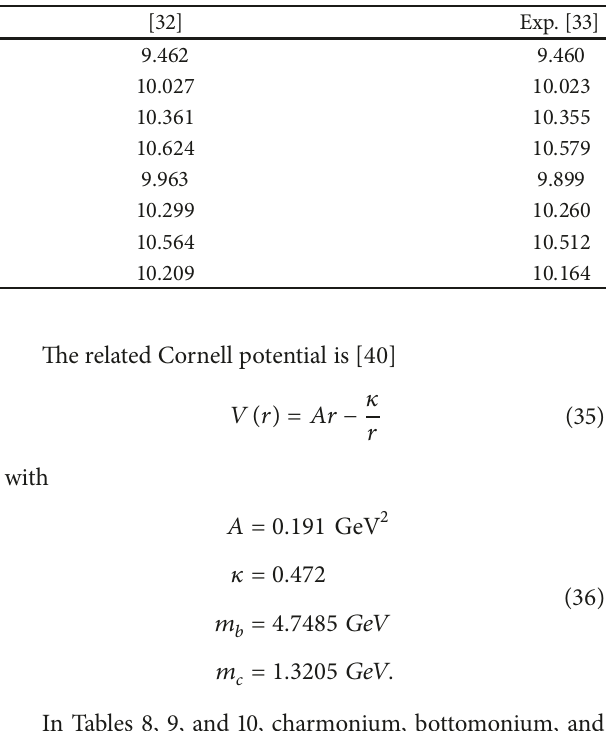
Table 9: Bottomonium spectra. All results are in